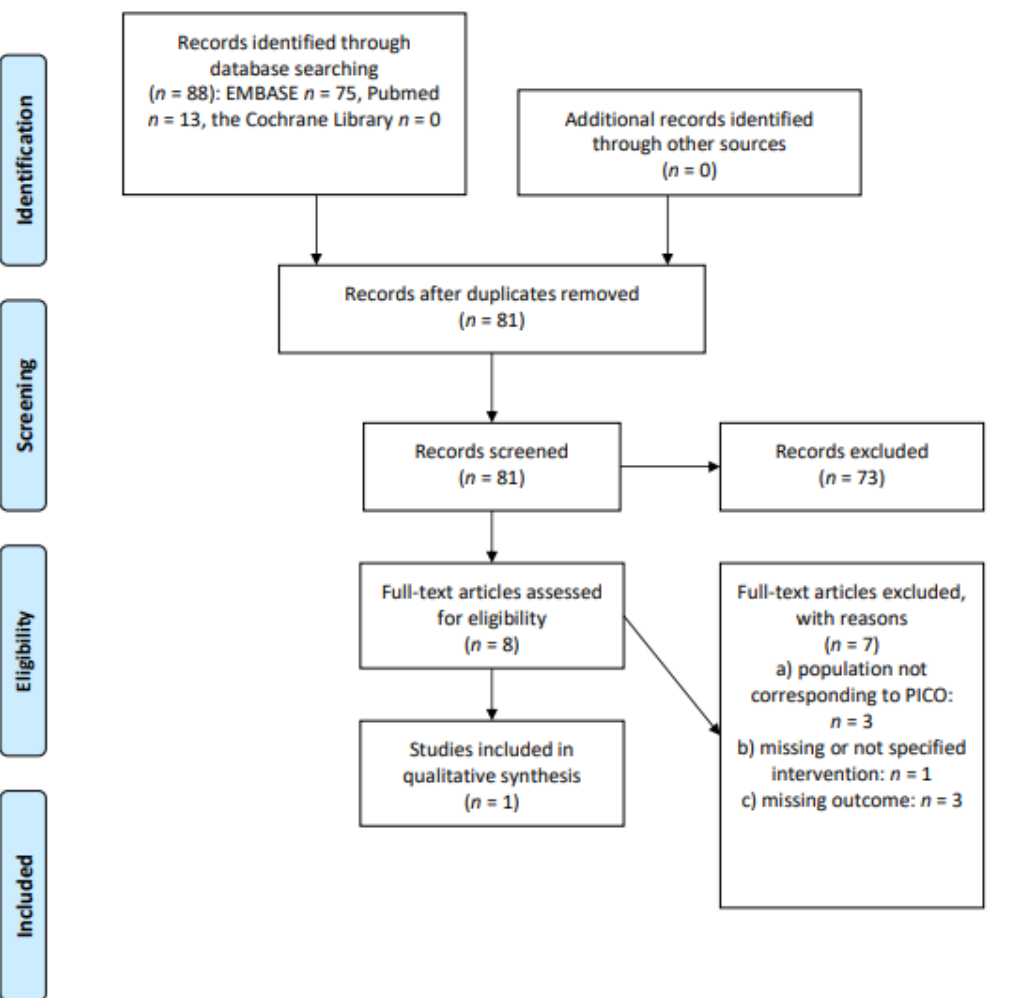
Figure 6. PRISMA flow-chart on survivorship care plans.